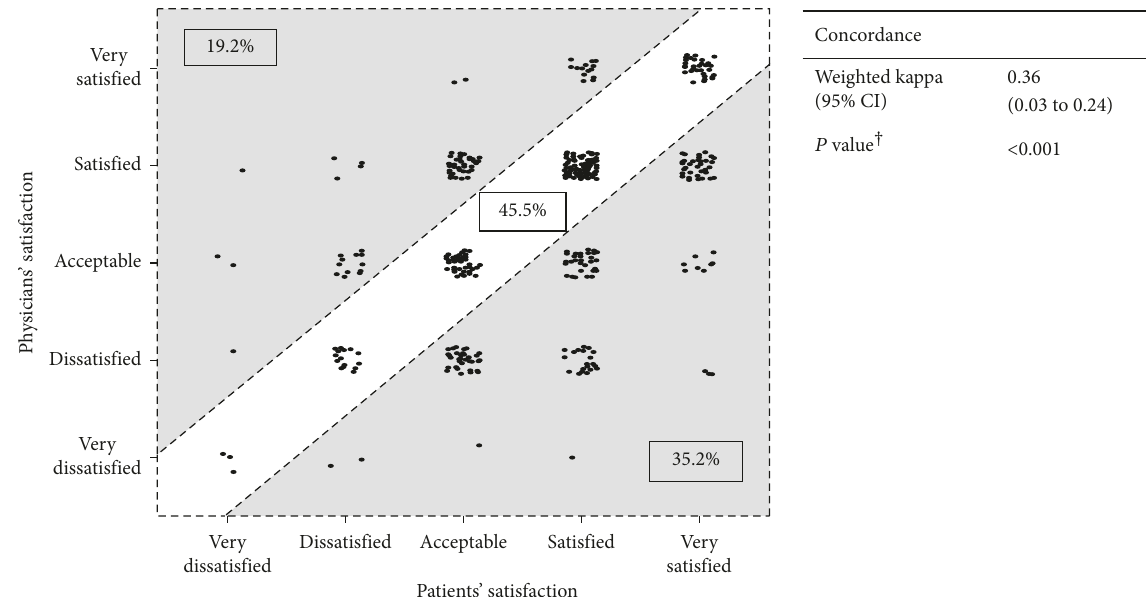
Figure 2: Concordance of patients’ and physicians’ satisfaction with patients’ pain control status ( n